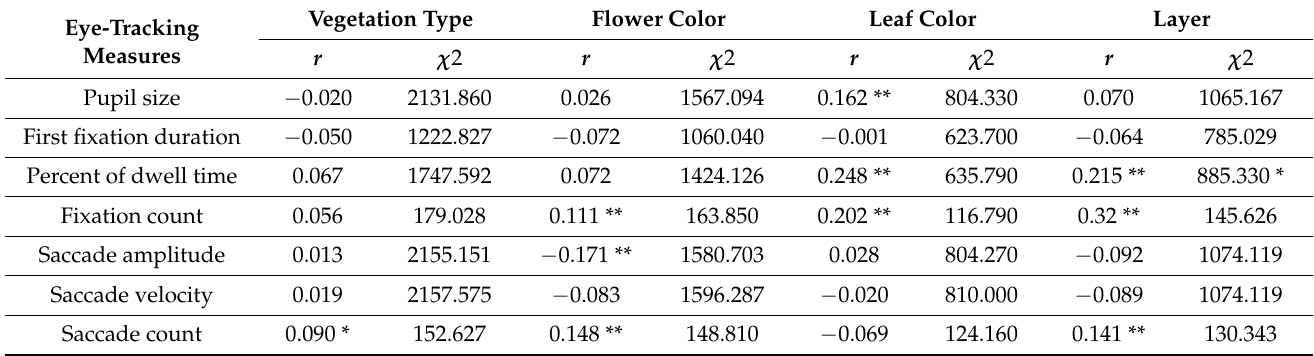
Table 1. Chi-square test of eye-tracking measures and subjective ratings of visual attributes.